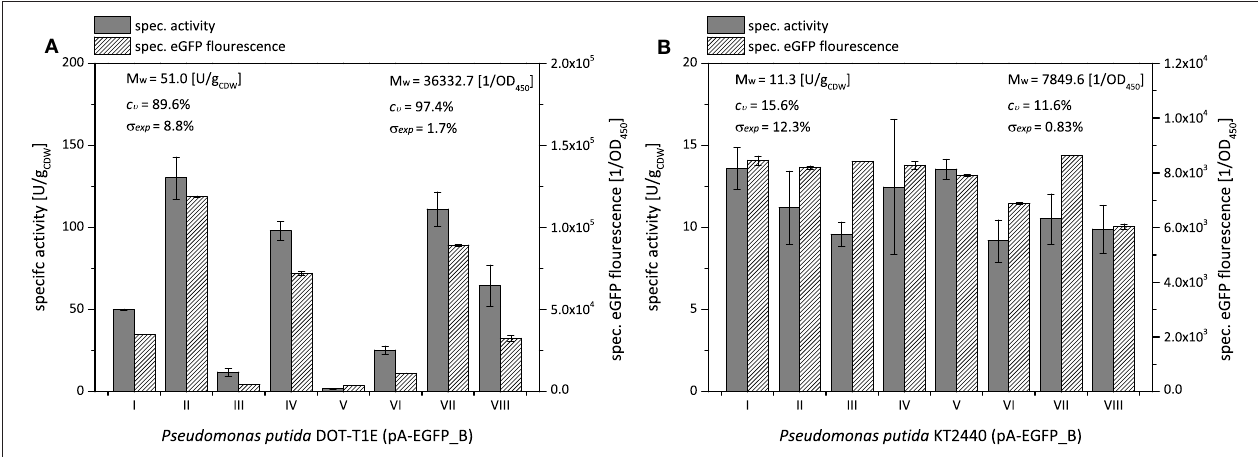
FIGURE 2 | Clonal variability in specific styrene epoxidation activity and styA-eGFP expression levels for P. putida DOT-T1E (A) and P. putida KT2440 (B) both harboring pA-EGFP_B. Specific styrene epoxidation activities and expression levels were determined via resting-cell activity assays and specific eGFP fluorescence, respectively. Exemplary results for 8 independent clones are shown. Cultures were induced with 0.025% (v/v) DCPK for 4h. SDS-PAGE analyses and induction kinetics of respective clones are shown in Figures S6, S7. Average specific styrene epoxidation activities M w [Ug − 1 CDW ], average specific fluorescence values [OD − 1 450 ], coefficients of variation c ν [%], and experimental errors σ exp [%] given correspond to 21 and 8 tested cultures of P. putida DOT-T1E (pA-EGFP_B) and P. putida KT2440 (pA-EGFP_B),